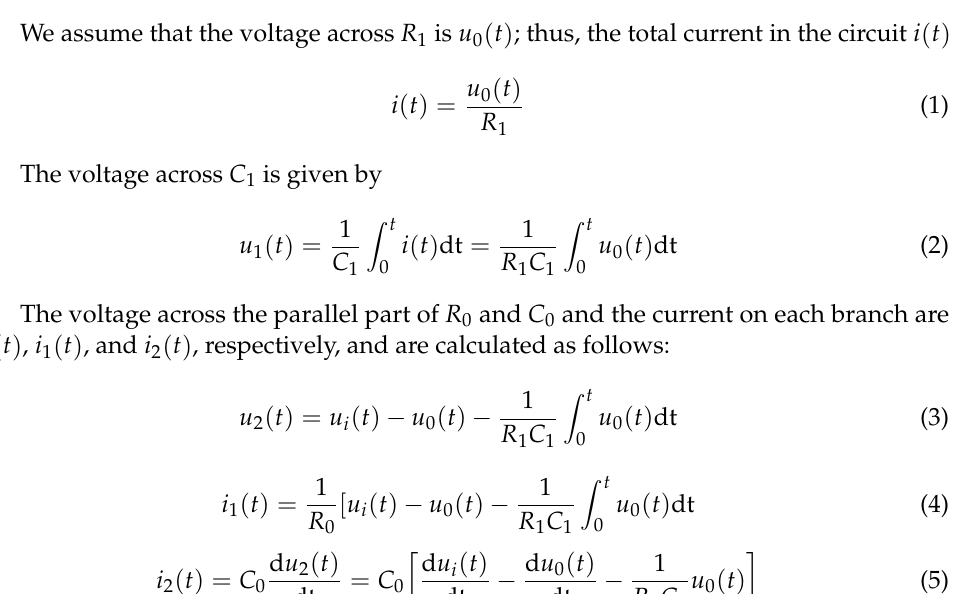
Figure 3. Equivalent electrical model.